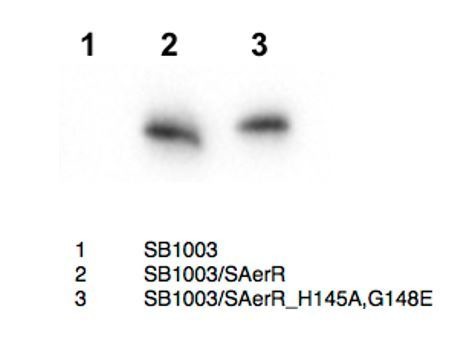
Western blot analysis of WT cell and cells that express flag tagged SAerR and flag tagged SAerR containing the Cbl binding mutations.Antibody used is to the flag epitope.